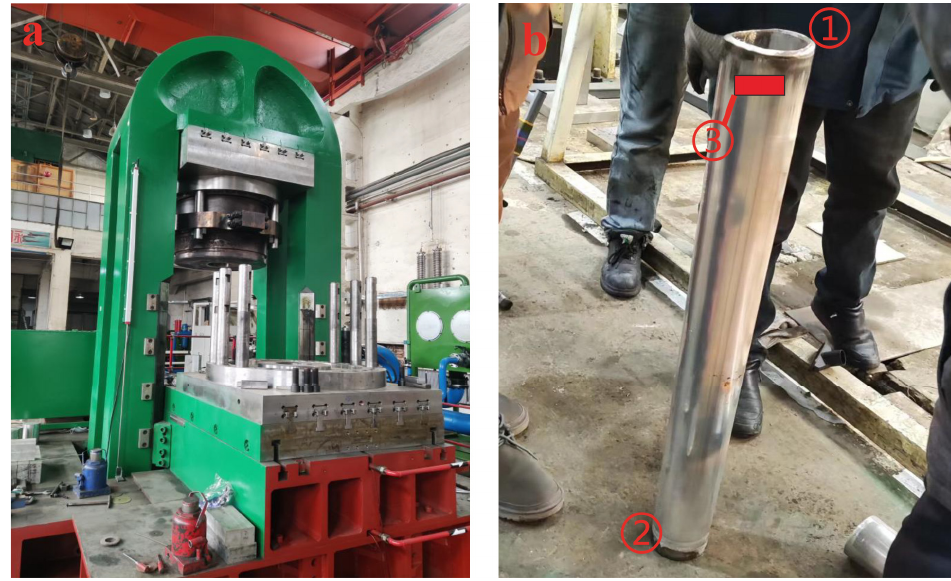
Figure 13. Extrusion pipe. ( a ) 35 MN extruding machine; ( b ) 2A12 pipe.